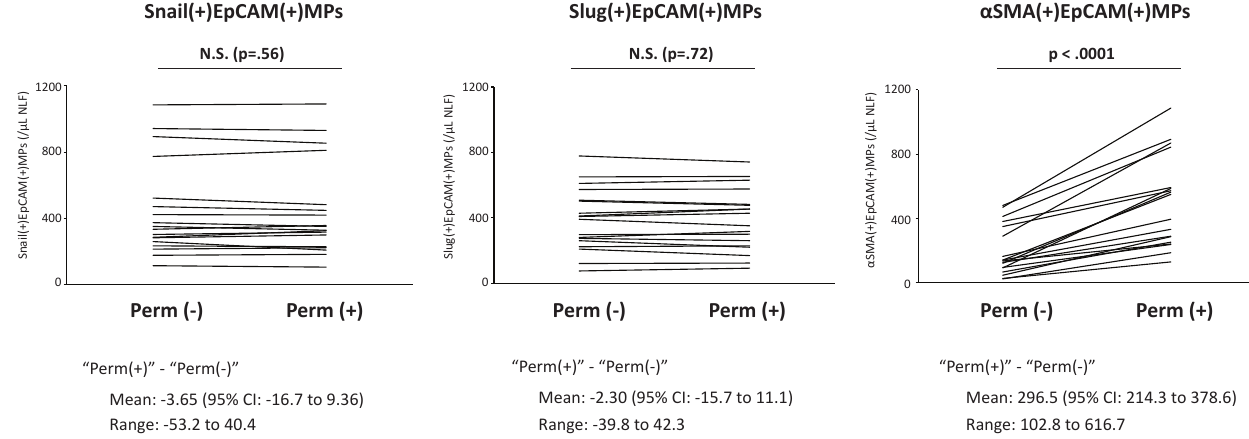
Figure 3. MP assay with and without permeabilization. We compared EpCAM(+)MPs using the MP assay either with or with- out permeabilization using NLFs collected from 18 subjects. Levels of Snail(+)EpCAM(+)MPs and Slug(+)EpCAM(+)MPs were not changed by permeabilization, although α SMA(+)EpCAM(+)MPs were increased by permeabilization ( p < 0 .0001). Perm (+): MP protocol with permeabilization, Perm ( − ): MP protocol without permeabilization. “Perm(+)” − “Perm( − )”: difference in MP levels between the MP assay with and without permeabilization. Adapted with permission from John Willey and Sons. Ltd., Allergy, Takahashi T, et al., 75, 3261–3289, copyright 5177010584585